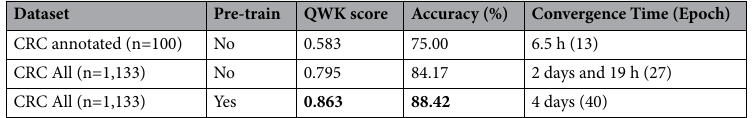
Table 7. Performance of the model on the different experiments on the CRC dataset. Bold values indicate best results